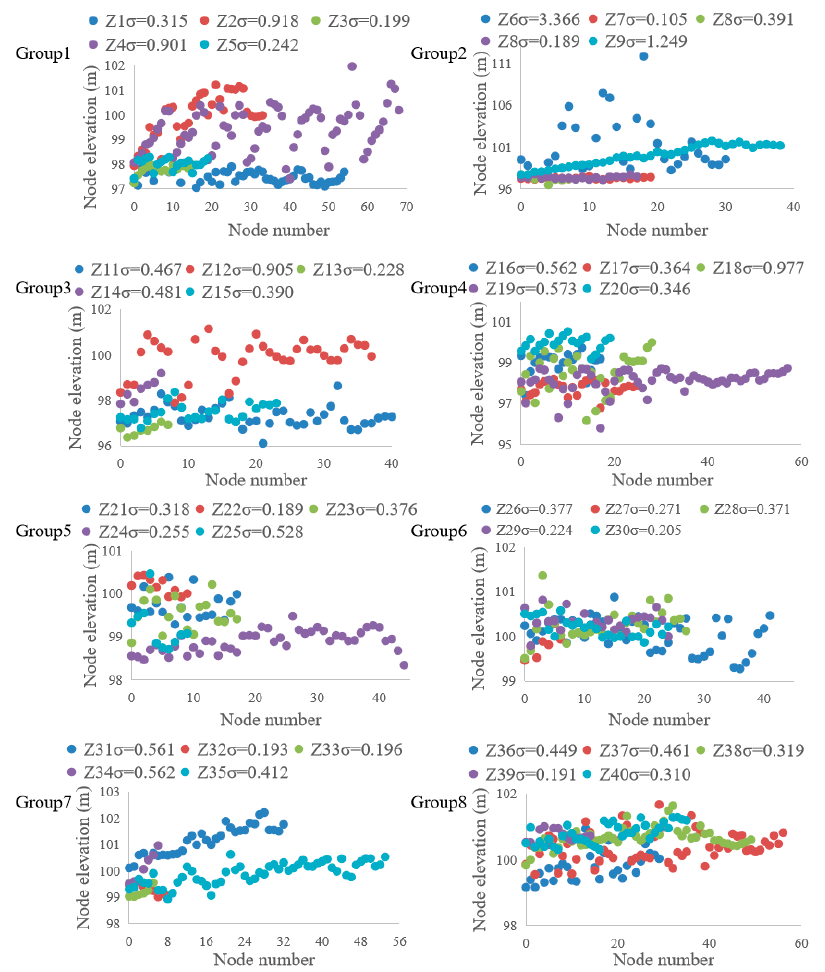
Figure 8. Elevation standard deviation of the original subcatchments. Hydrology 2020 , 7 , 26